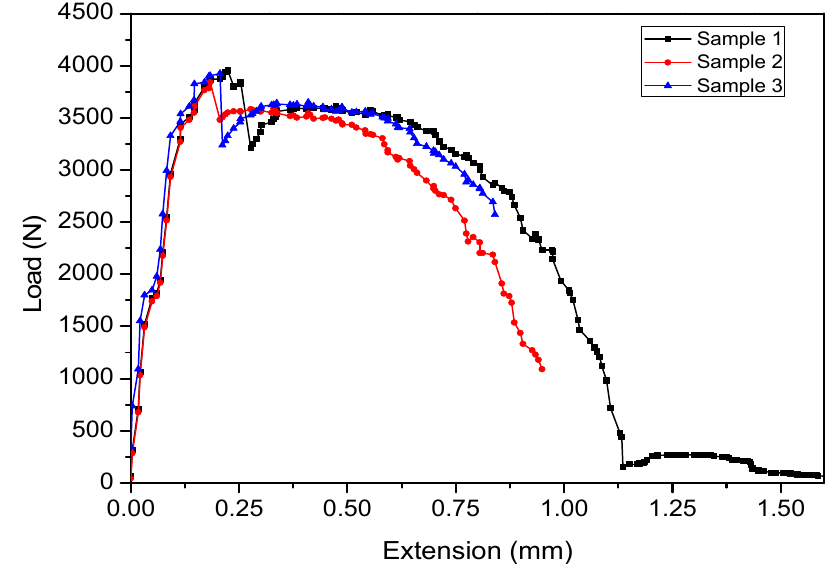
Figure 15. Result of the lap ‐ shear tests of spot joints made by 8 kJ of discharge energy.